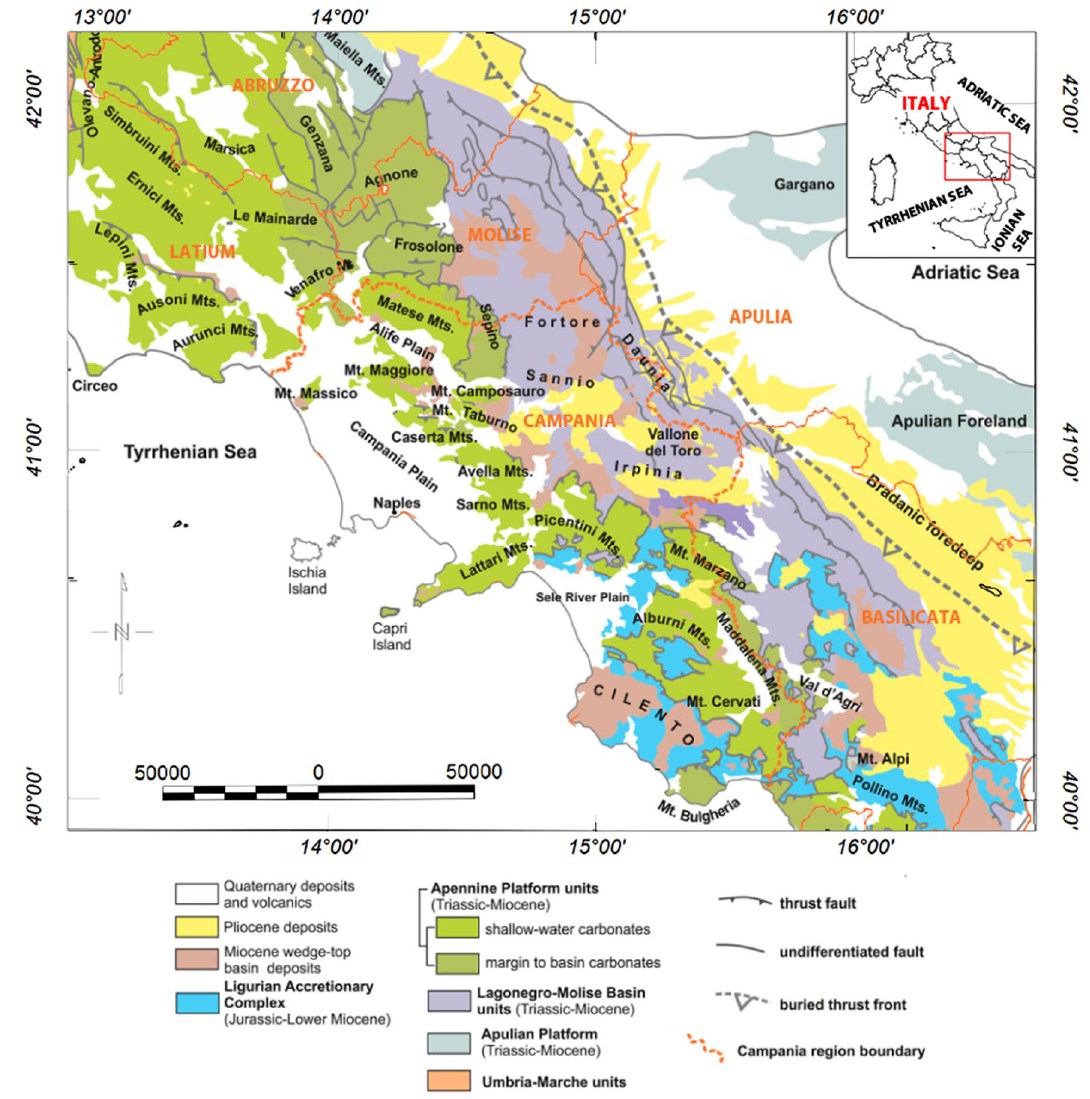
Figure 1. Sketch geological map of the Southern Apennines (modified after 36 ). The map was generated using the Oasis Montaj Geosoft software (v.9.9.1.34 https:// www. seequ ent. com/ produ cts- solut ions/ geoso ft- oasis-